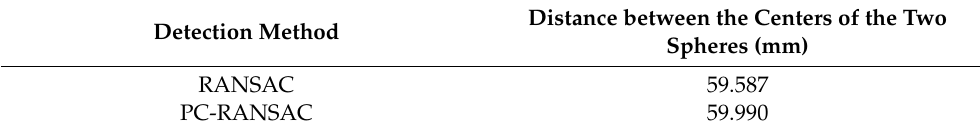
Table 3. Average sphere center distance detected by each